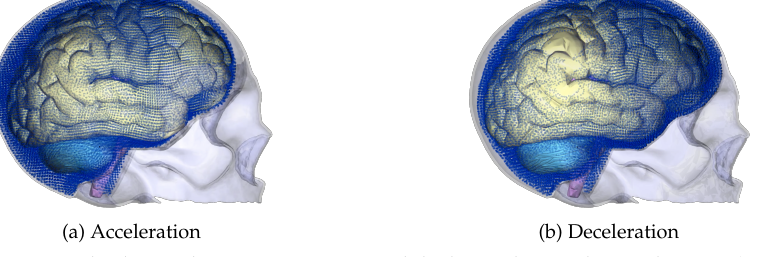
Figure 5. Fluid particles positioning around the brain during the acceleration (coup) and deceleration (contrecoup) phases.